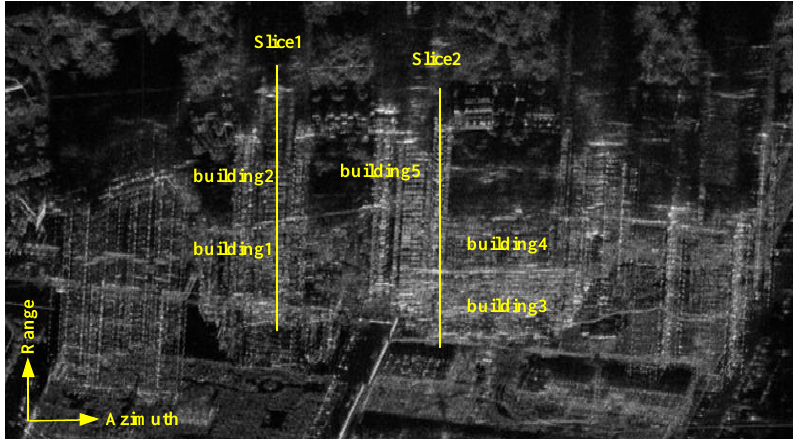
Figure 15. Optical image of the studied scene in Experiment 2. ( a ) Image 1. ( b ) Image 2.